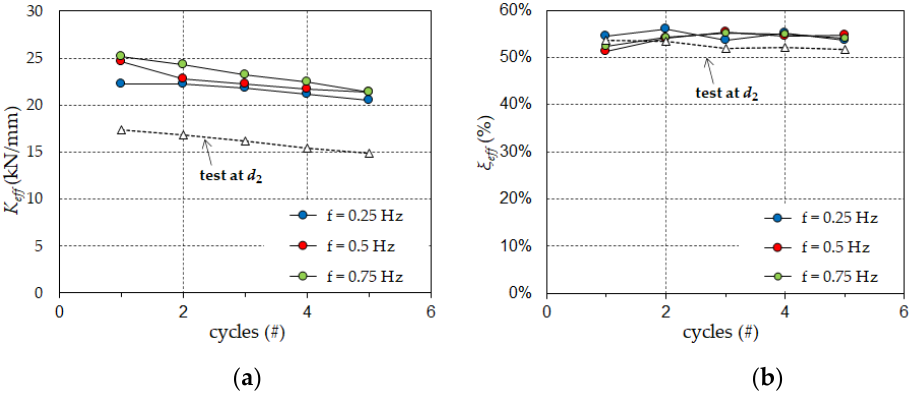
Figure 10. Variation of the properties of the PS-LED prototype in cyclic tests at different frequencies f with maximum deflection d 2 (design deflection at the collapse ultimate limit state): ( a ) the effective stiffness K eff and ( b ) the equivalent damping ratio ξ eff .